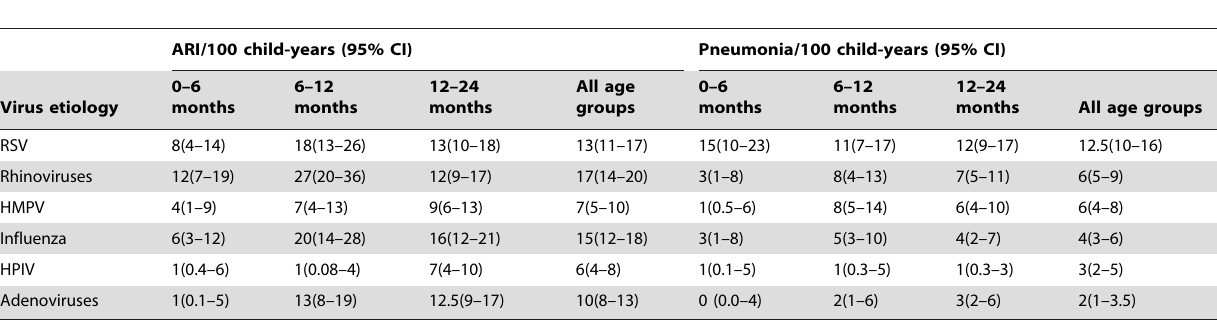
Table 3. Incidence of ARI and pneumonia per 100 child-years associated with different respiratory viral pathogens in a cohort of children aged , 2 years in a low income urban neighborhood, Dhaka, Bangladesh (April 2009–March